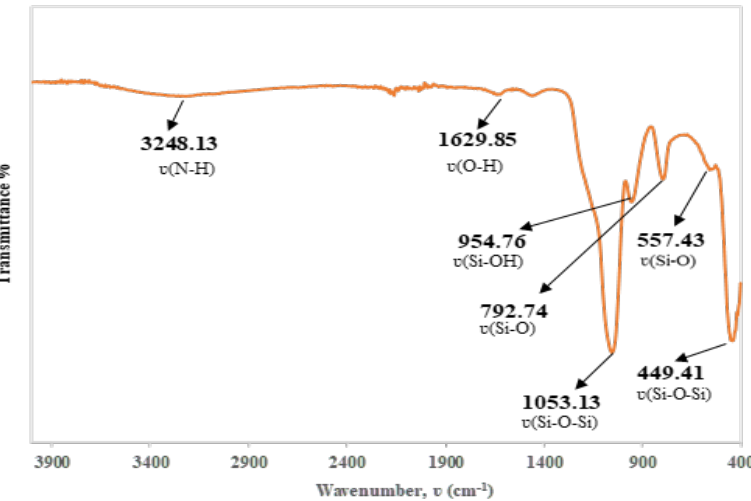
Figure 1. Fourier transform-infrared (FTIR) spectra of functionalized SiNPs.